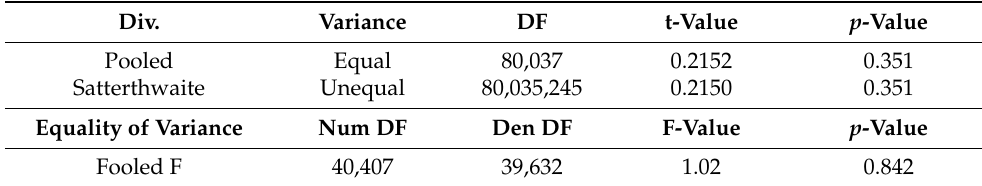
Table 9. Two-sample t -test for H1b testing.